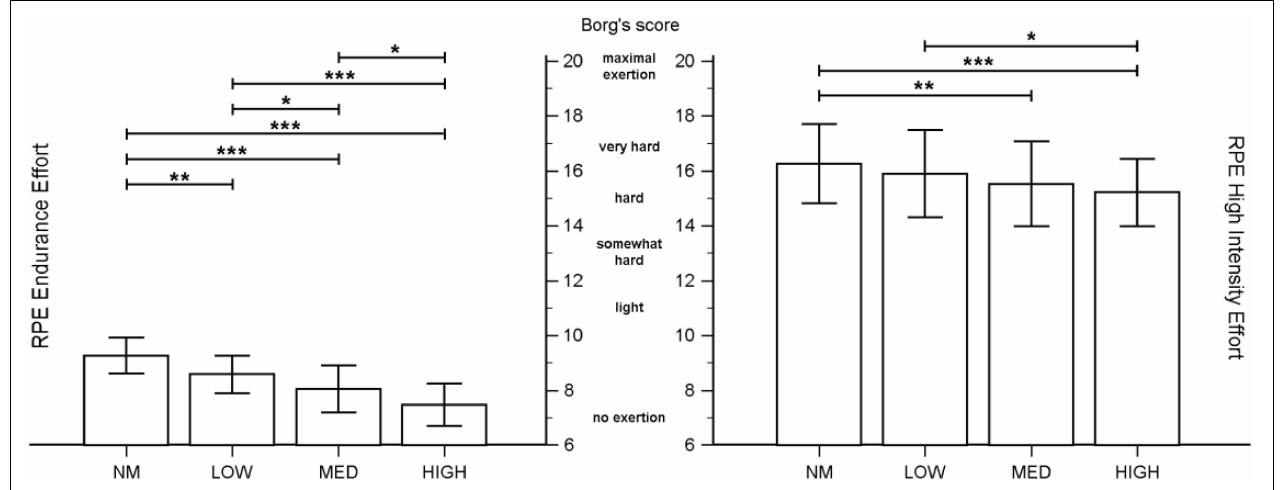
FIGURE 1 | Rating of perceived exertion (RPE) in both exercises during the four conditions. * p < 0.05; ** p < 0.01; *** p <